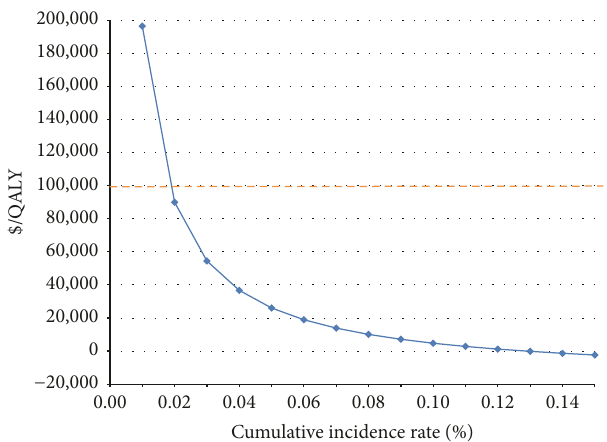
Figure 2: One-way sensitivity analysis: impact of annual cumulative incidence on ICER (universal screening relative to standard of care in the DC